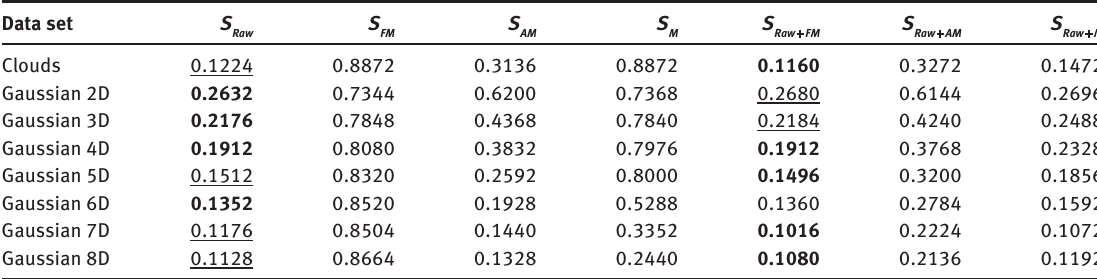
Table 6: SVM Misclassification Rates on the Eight Highly Overlapping Two-Class Synthetic Data Sets. Data set